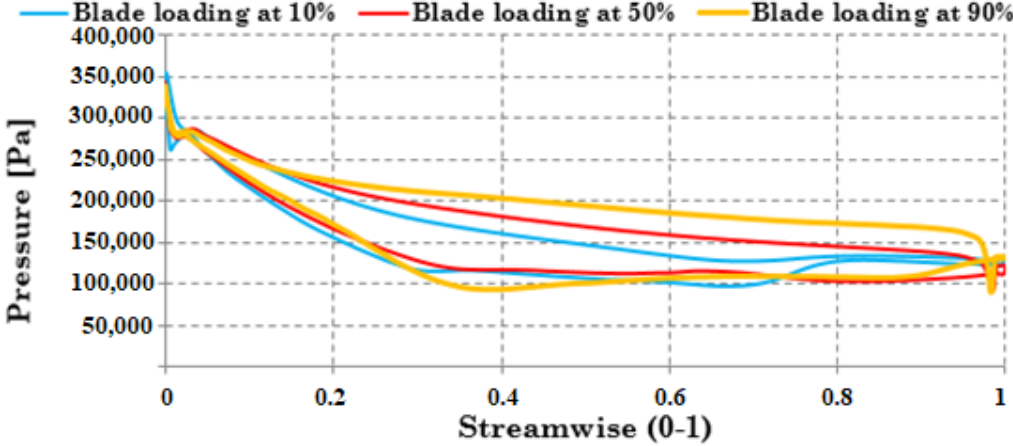
Figure 20. Blade loading through the rotor blades.